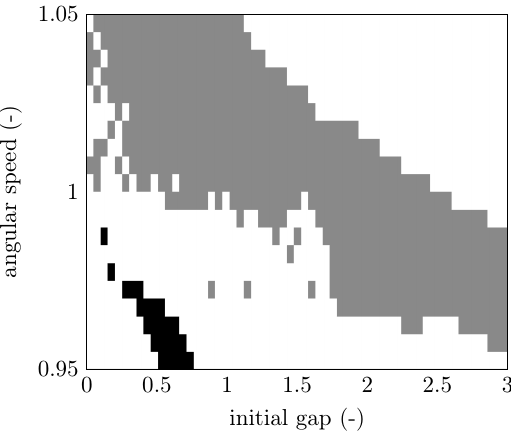
Figure 30. Number of wear lobes depending on the angular speed and the initial clearance for the LP compressor blade. ( ): 7 wear lobes, ( ): 15 wear